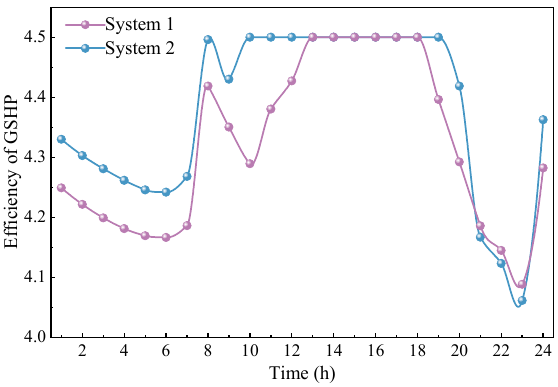
Figure 8. The efficiency of GSHP in System 1 and System 2.